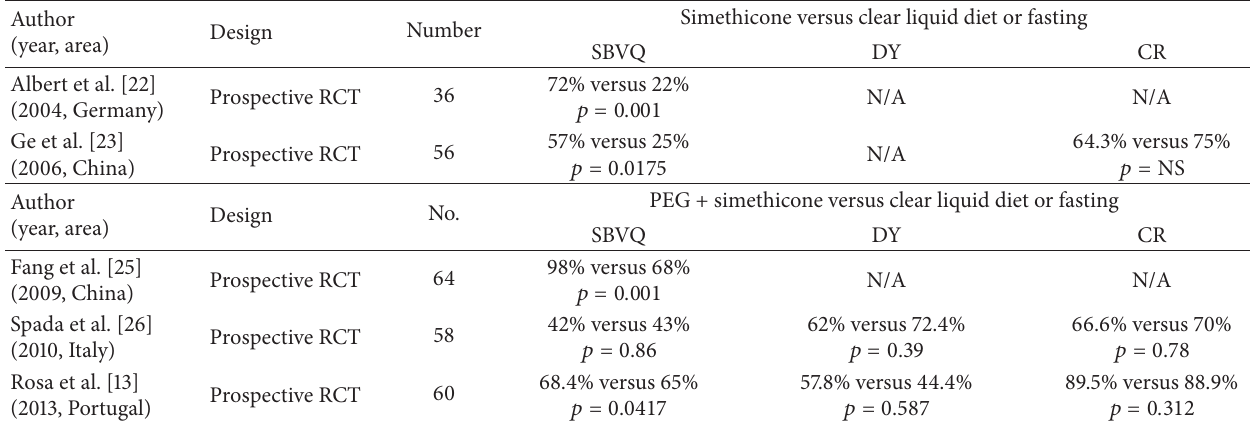
Table 4: Studies comparing SBVQ, DY, and CR between simethicone versus clear liquid or fasting of small bowel